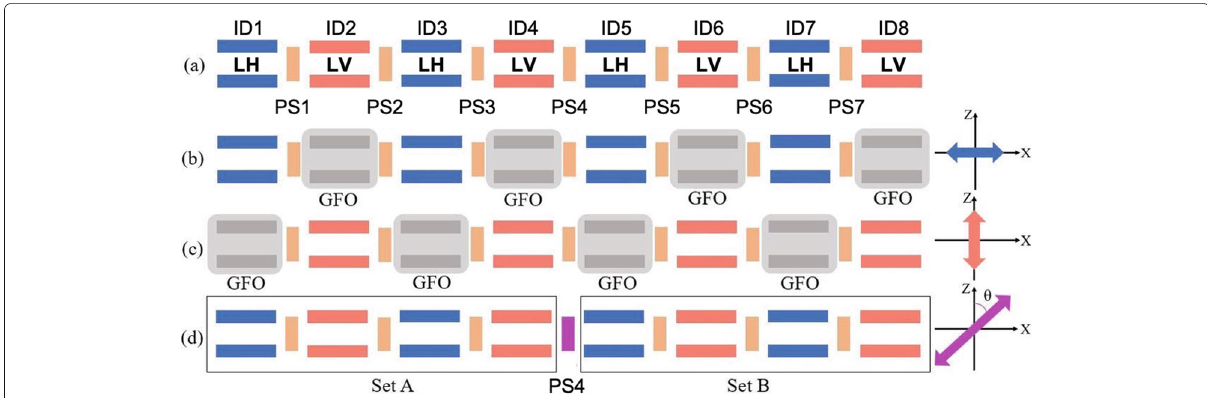
Fig. 18 Polarization control using an SCU at BL07LSU of SPring-8 [33]. a Schematic of the undulator composed of eight insertion device (ID) segments and seven PSs. b , c Production of horizontal and vertical polarization by activating odd- and even-numbered IDs only, respectively. GFO means the gap full open. d Azimuthal-angle rotation of linear polarization. Circularly polarized light with opposite helicity yielded by the front and rear four IDs are superimposed with a phase difference set by PS4 in between